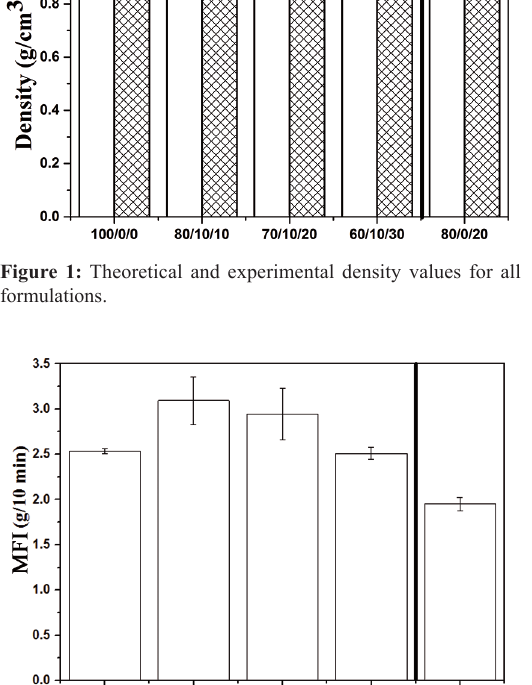
Figure 3: (a) Thermogravimetric analysis curves and (b) Weight loss versus temperature First derivative